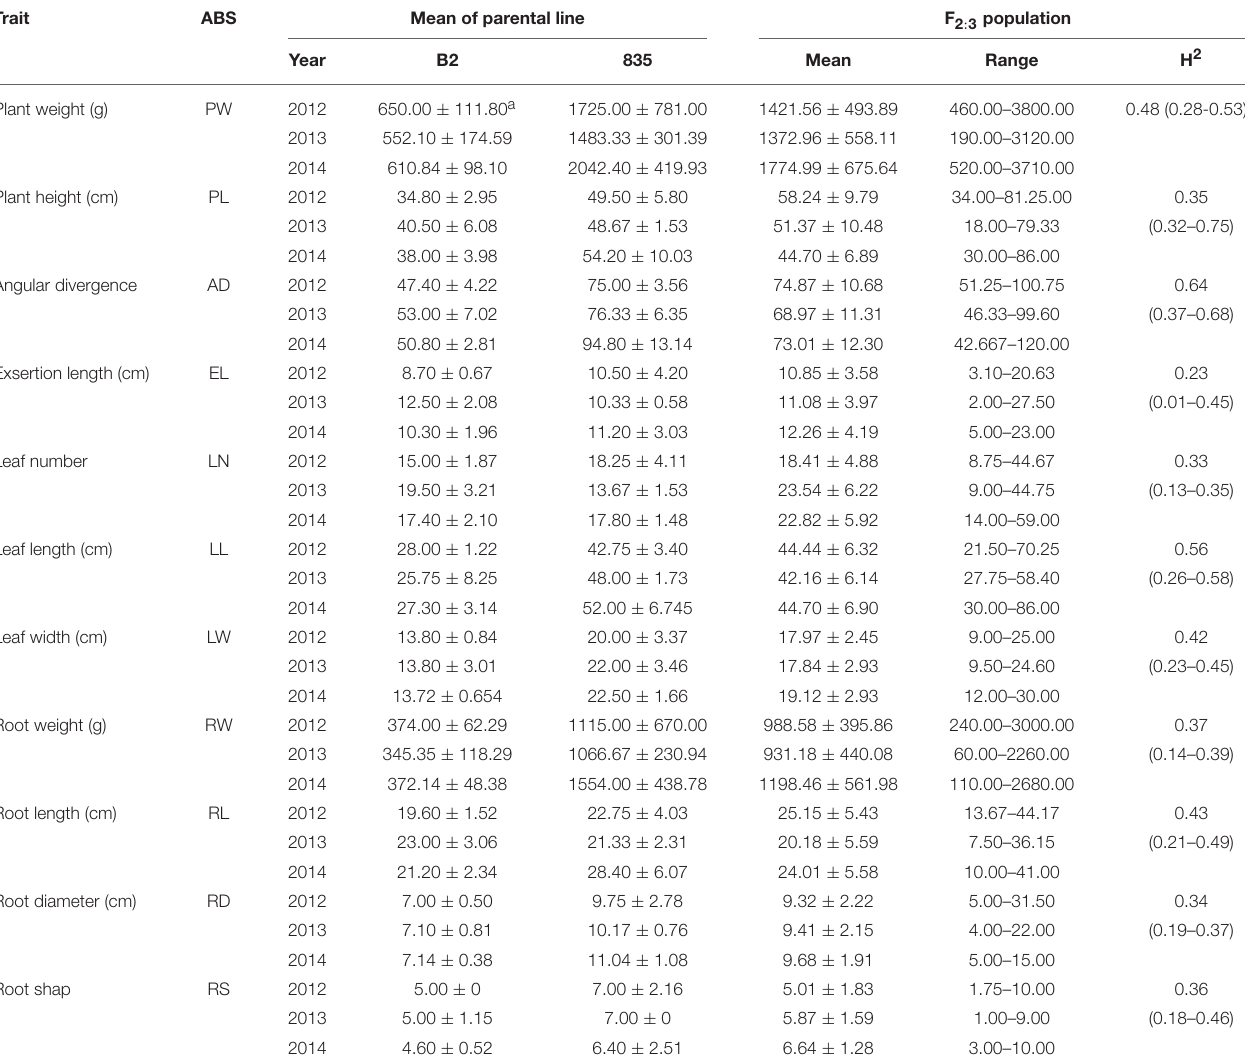
TABLE 1 | Means, ranges, and broad heritabilities (H 2 ) estimated for 11 traits in parental lines and F 2 : 3 generation.